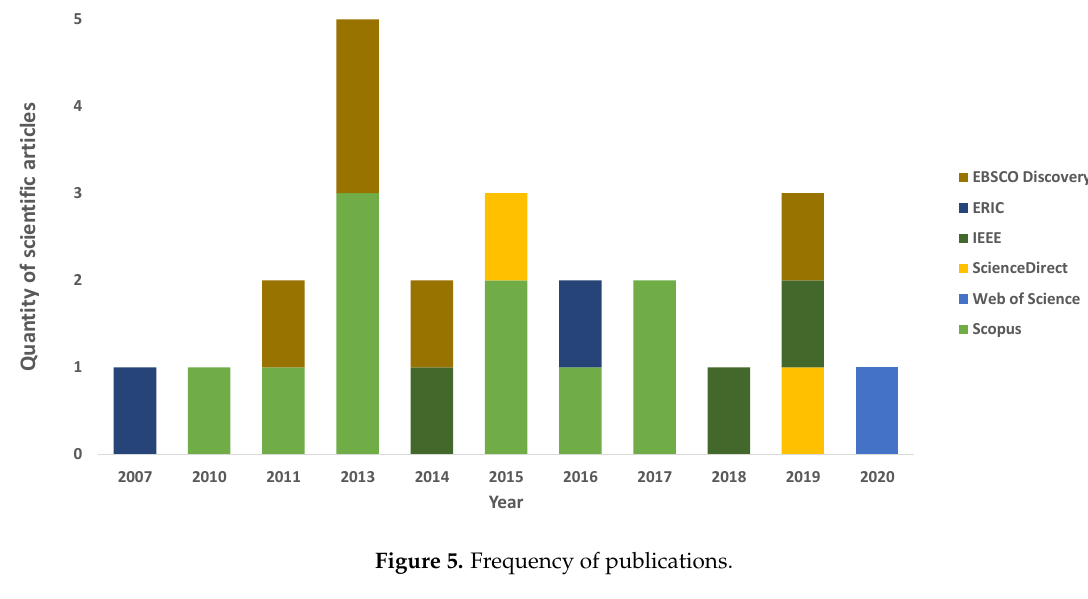
Figure 5. Frequency of publications.